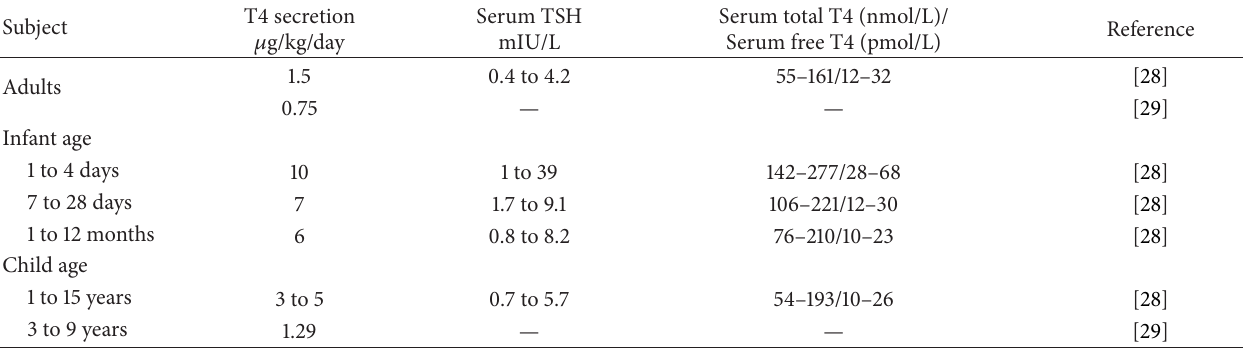
Table 4: Estimated secretion rates of thyroxine (T4) and total and free serum concentrations of T4 in infants, children, and